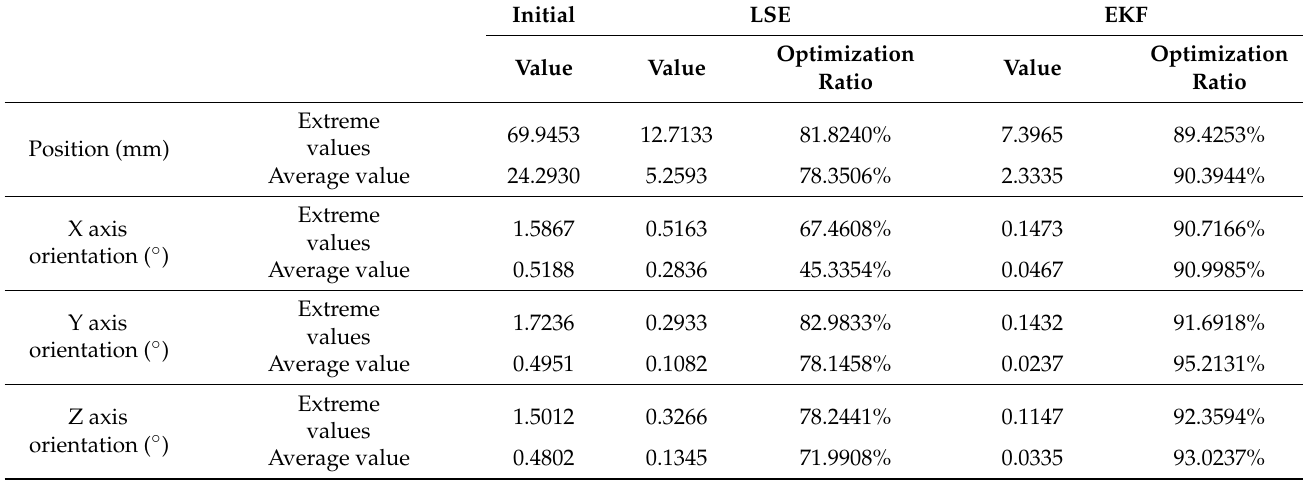
Table 4. Optimization effect of the position error of the calibration experiment.